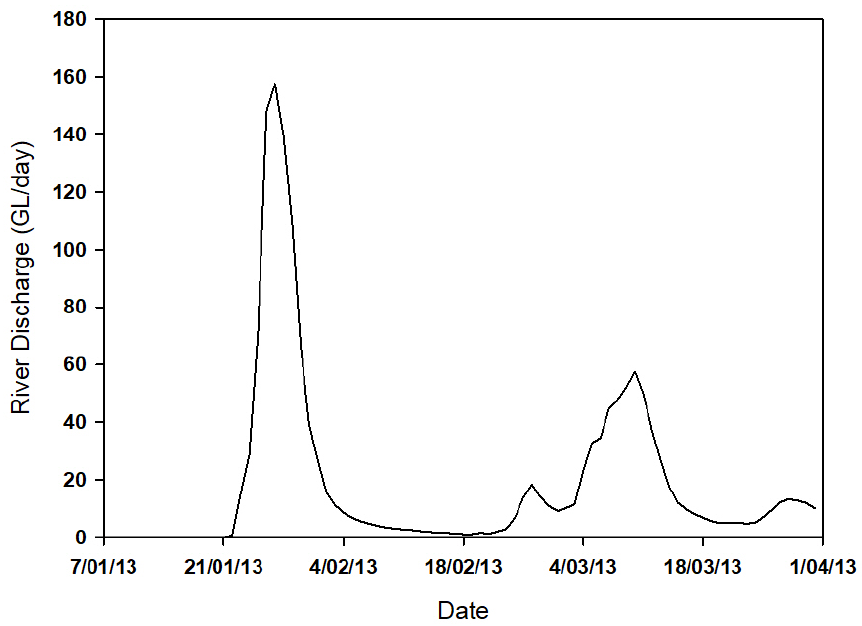
Figure 2. Riverine discharge at the Kalpowar Crossing gauging station in the Normanby (105107A, located 77 km upstream from the Normanby river mouth).